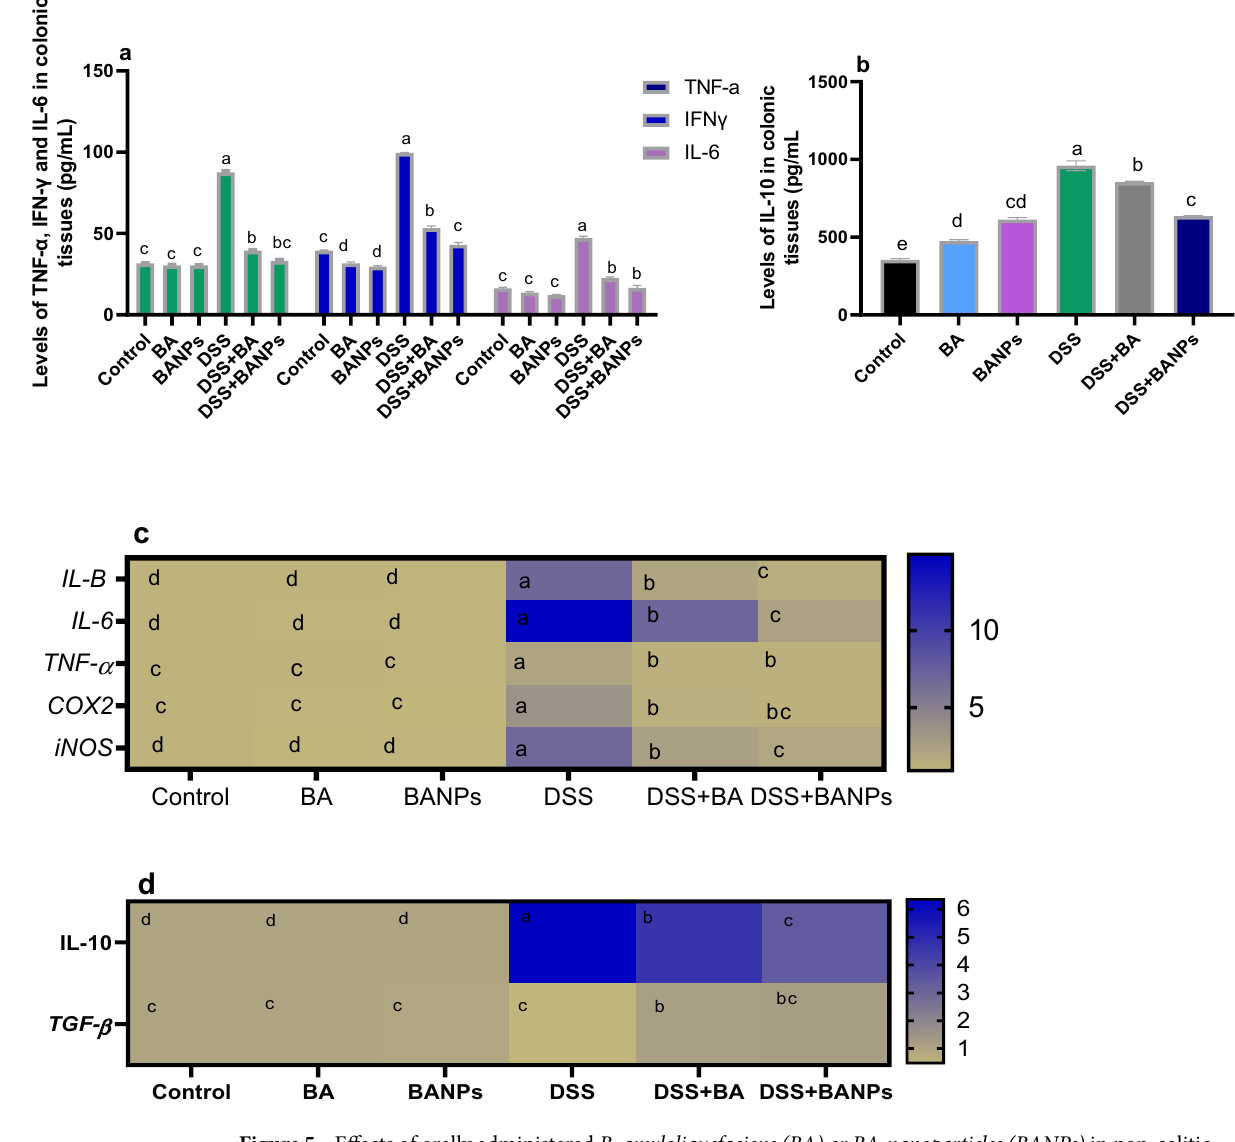
Figure 5. Effects of orally administered B. amyloliquefaciens (BA) or BA-nanoparticles (BANPs) in non-colitic and colitic rats on measurement of cytokines protein levels by ELISA kits ( a , b ) and heat map illustrating mRNA of various inflammatory markers including cytokines by real time PCR ( c , d ) 7 days post DSS induction. Interleukin (IL)-1β, IL-6, IL-10, tumor necrosis factor α (TNFα), transforming growth factor-beta (TGF-β), cyclooxygenase-2 (COX-2) and Inducible nitric oxide synthase (iNOS). Non-colitic groups including Control, BA and BANPs groups where rats were orally gavaged PBS, B. amyloliquefaciens and B. amyloliquefaciens loaded nanoparticles (BA at level of 1.0 × 10 10 CFU/kg in 1 mL of PBS/rat/day), respectively, for 7 days. Colitic groups: DSS, BA and BANPs groups where rats were orally gavaged dextrane sodium sulphate (DSS), B. amyloliquefaciens + DSS and B. amyloliquefaciens loaded nanoparticles (BA at level of 1.0 × 10 10 CFU/kg in 1 mL of PBS/rat/day) + DSS , respectively, for 7 days. All groups orally gavaged by 5% DSS. Values are expressed as mean ± SE, a,b,c Means of the bars with different letters were significantly different among groups ( P < 0.05). The scale bar on the right side described the unit for each color as blue and light green squares corresponded to significant upregulation and downregulation, respectively of genes relative to the control groups (P <